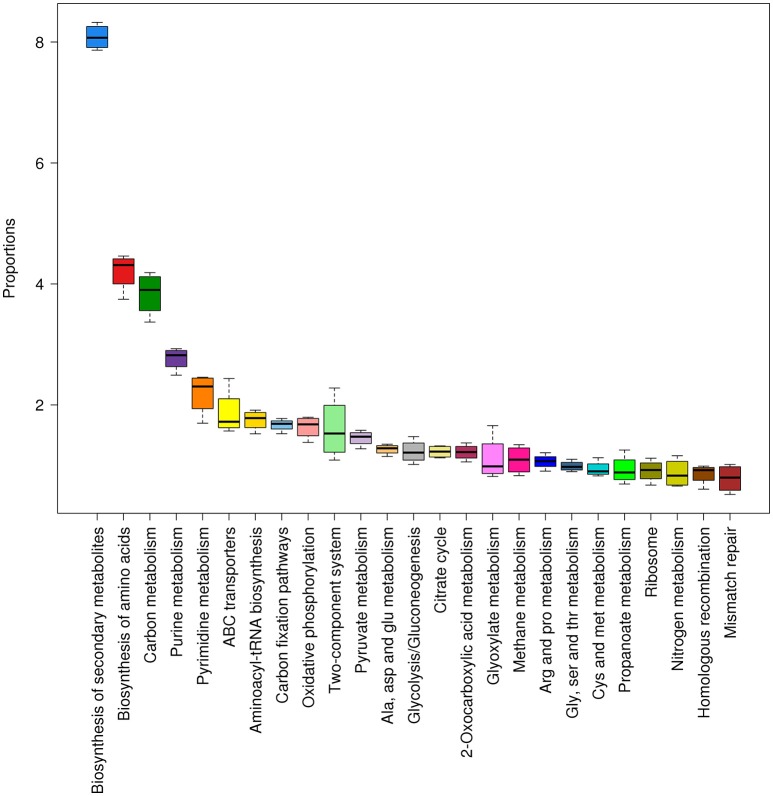
Abundant KEGG pathways found in Tattapani samples. The pathways and their proportions in Tattapani samples are shown using box plots (≥1% proportion). The samples showed a higher abundance of pathways for general cell functions and certain specific functions such as nitrogen metabolism and methane metabolism.